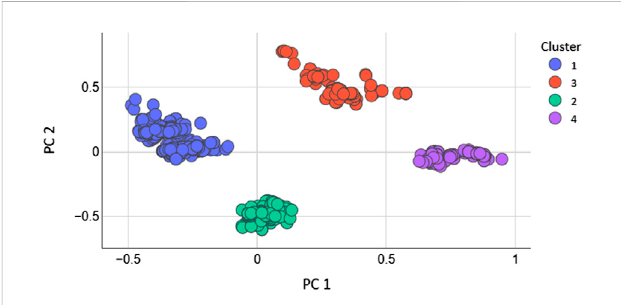
FIGURE 2 Scatter plot of PC1 vs. PC2 for subset 23 and K